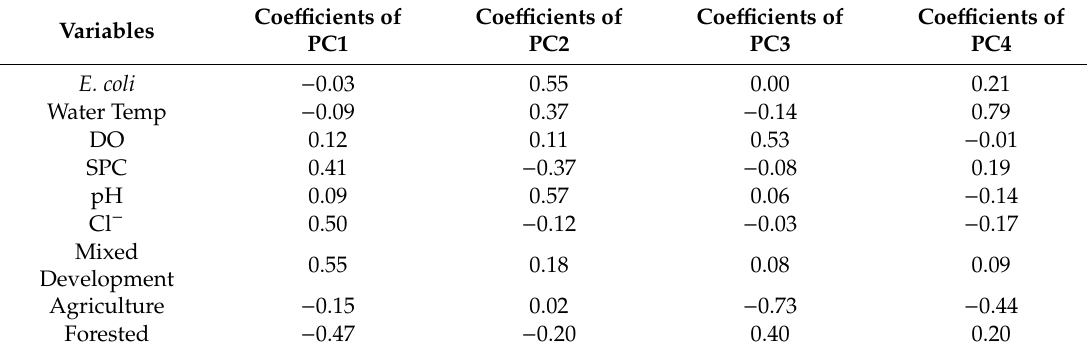
Table A11. Coe ffi cients of annual principal components comprising 9 variables ( E. coli concentration, water temperature, DO, SPC, pH, chloride, percentage of mixed developed land use, percentage of agricultural land use and percentage of forested land use) used to define 9 principal components during quarter four (fall: 2 October 2018–1 January 2019) in West Run Watershed, WV,